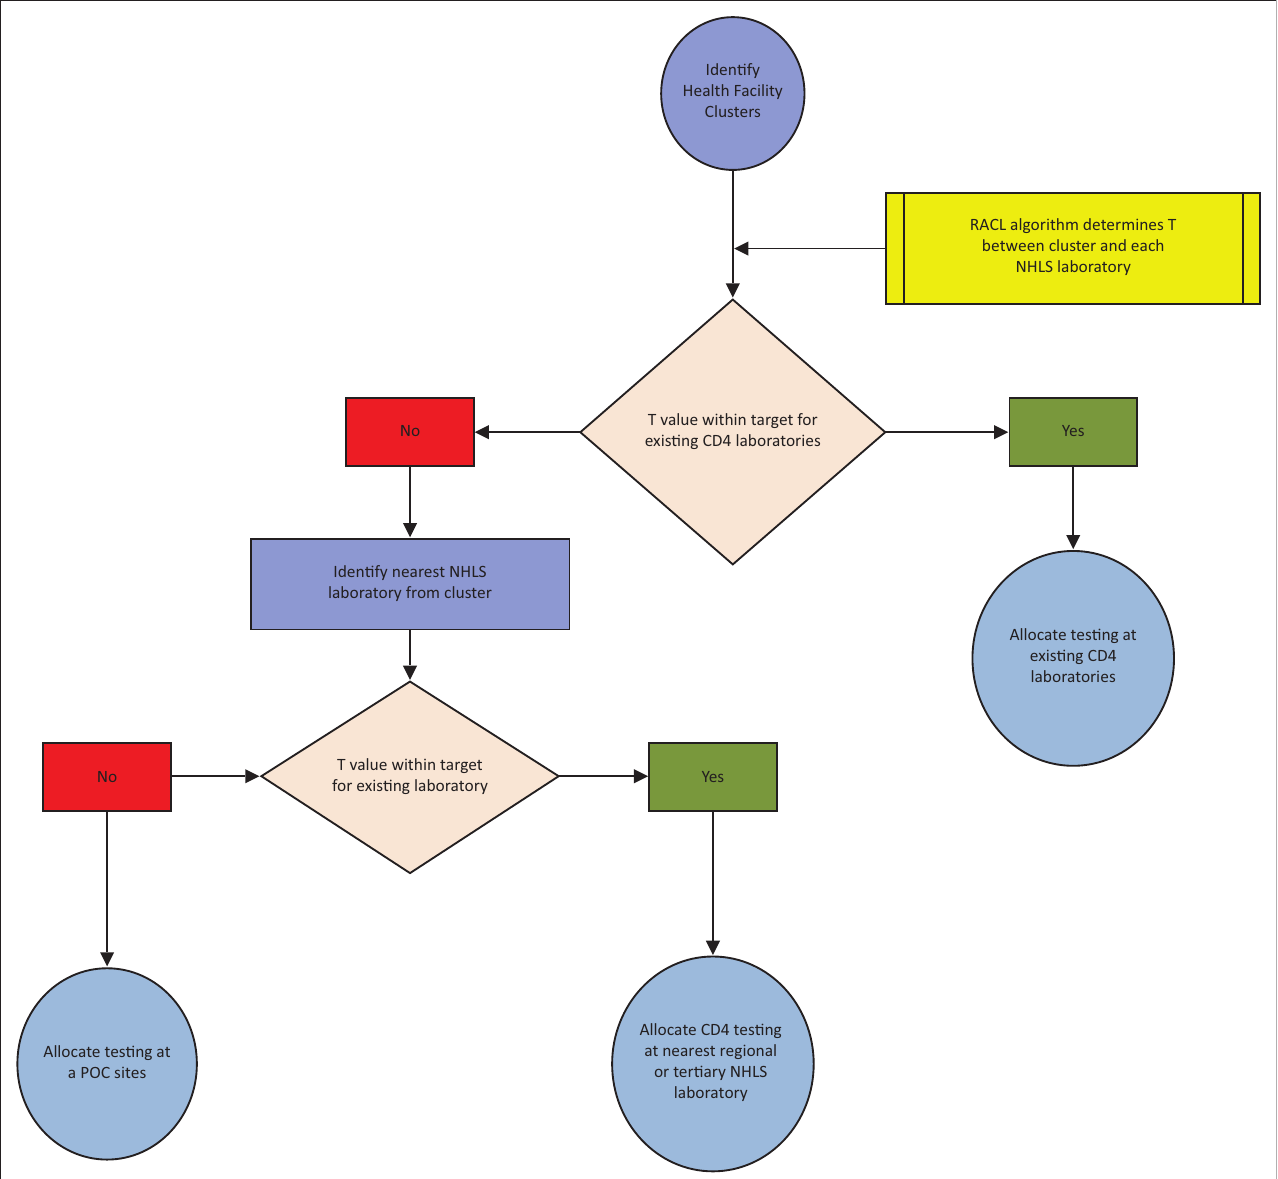
FIGURE 2: Flow chart of the steps followed by the RACL